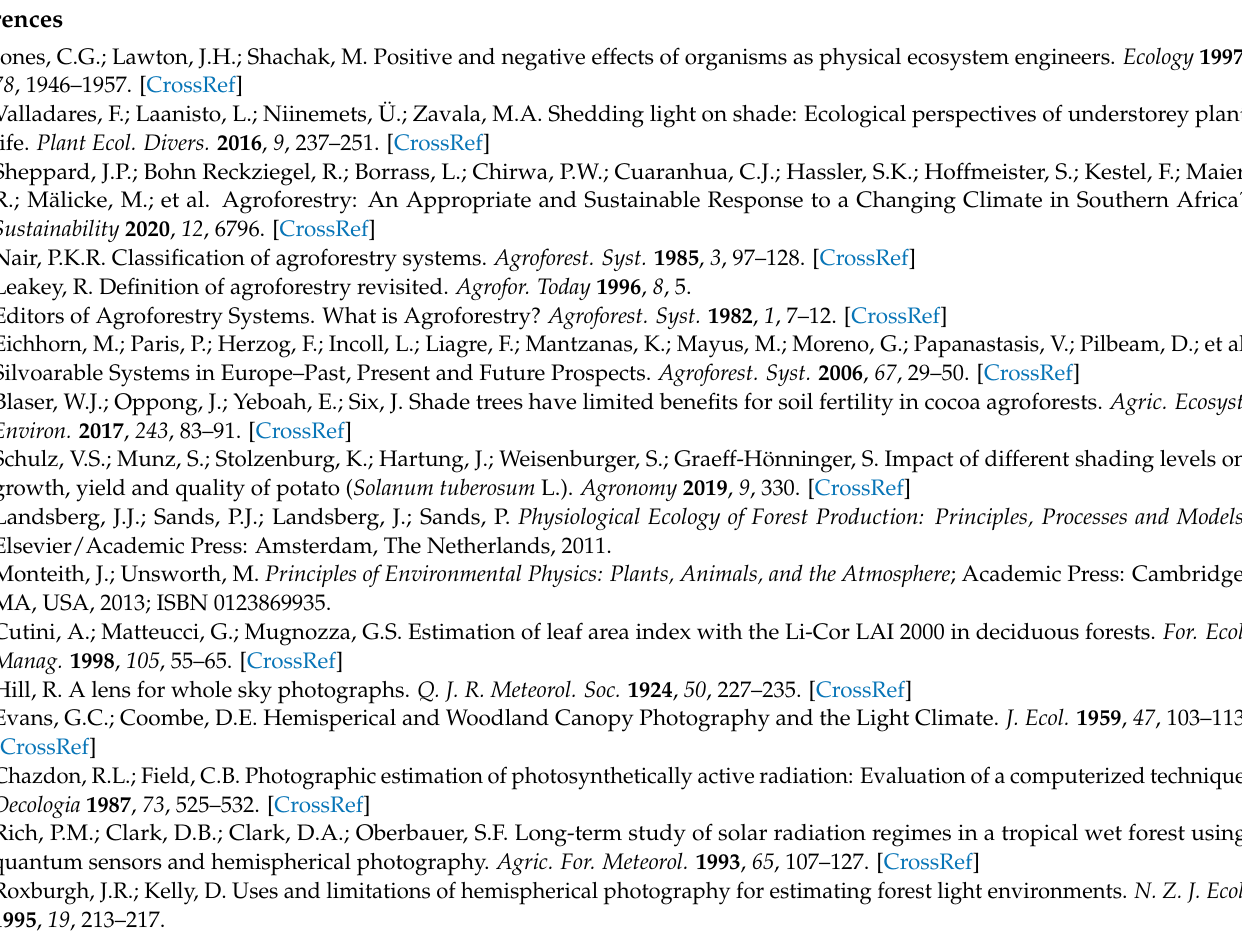
per leaf class. Table S2: Leaf attributes that define the leaf geometry points, from which six geometric points are derived: length, width, lower and upper edges. Table S3: Shaded area and insolation reduction of wild cherry trees ( Pa_1 to Pa_6 , in symbols) for different leaf modes (RL, EL, and NoL) and HP. Video S1: Wild cherry tree Pa_5 reconstructed as a QSM and augmented with the leaf modes; profile and top